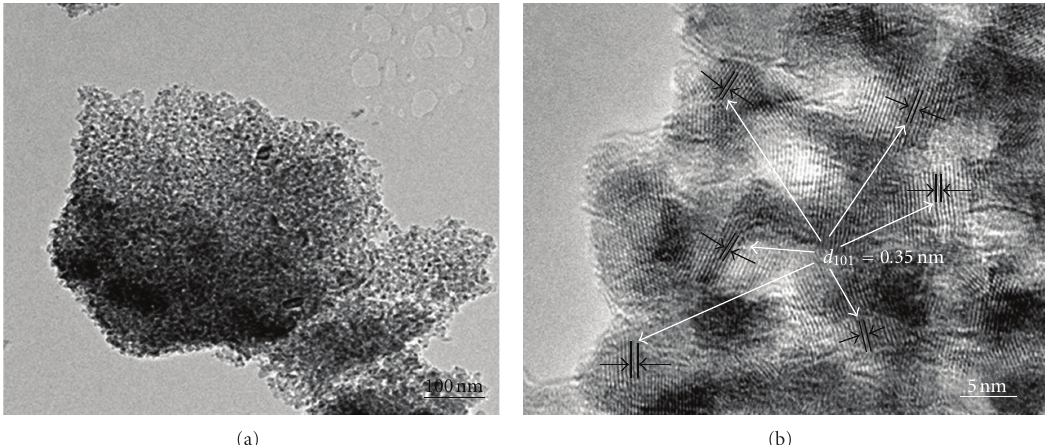
Figure 2: TEM (a) and HRTEM (b) images of N-Cl-codoped TiO 2 photocatalyst.